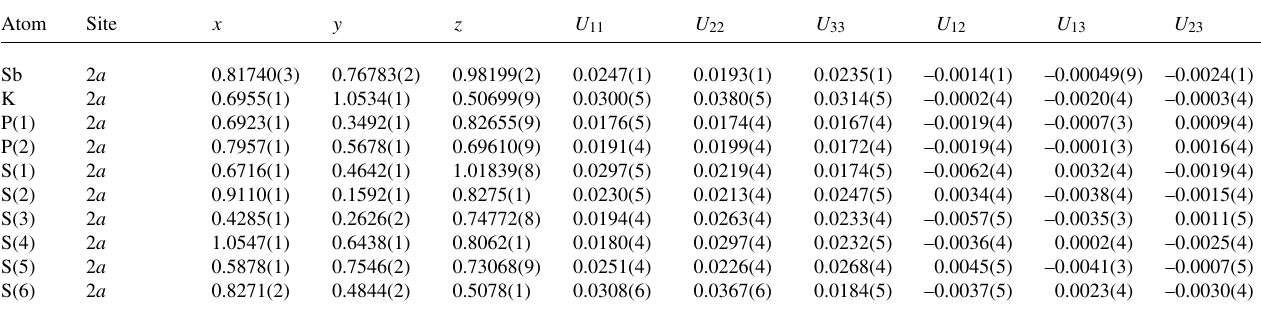
Table 2. Atomic coordinates and displacement parameters (in Å 2 ) .